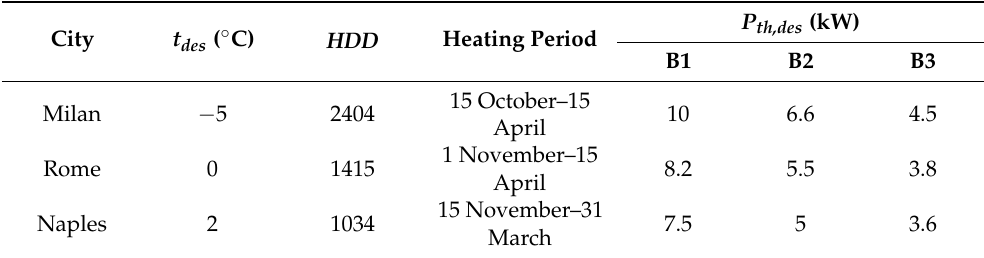
Table 4. Winter design temperature, HDD and heating system operation period characteristics of the three municipalities considered.